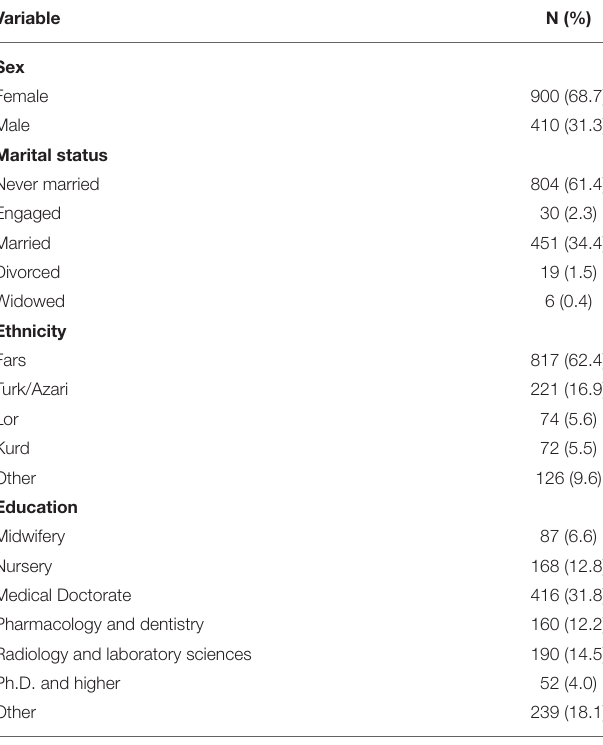
TABLE 2 | Knowledge of participants regarding famous symptoms and red flags of COVID-19. Symptoms/Red flags